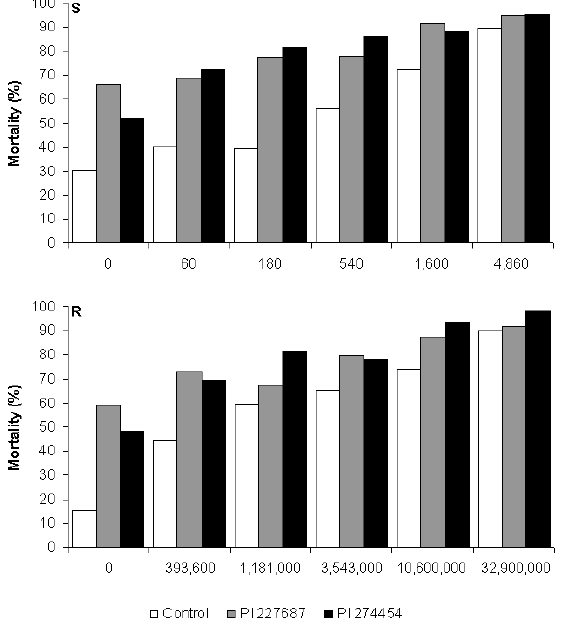
Fig. 1 – Percentage of mortality of Ag MNPV-susceptible (S) and re- sistant populations (R) of Anticarsia gemmatalis fed on artificial diet (control) or plus soybean extracts (PI 274454 and PI 227687) and their interactions with six concentrations of the